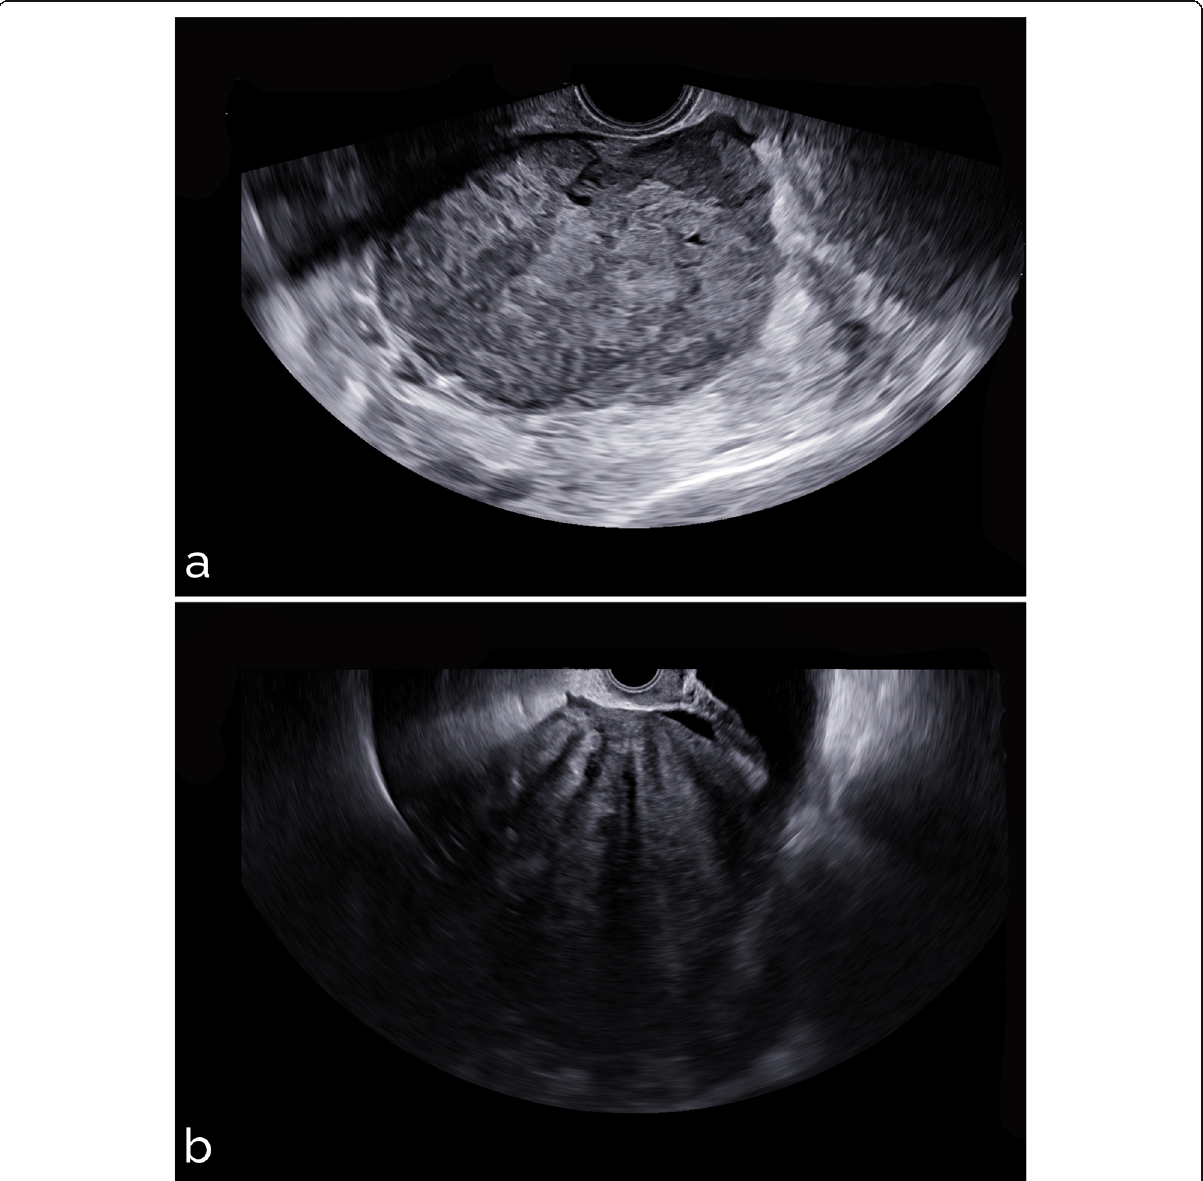
Fig. 7 Transvaginal ultrasound of solid ovarian masses: ( a ) clear cell ovarian cancer on histological examination (medium-high risk), ( b ) ovarian fibroma on histological examination (very low